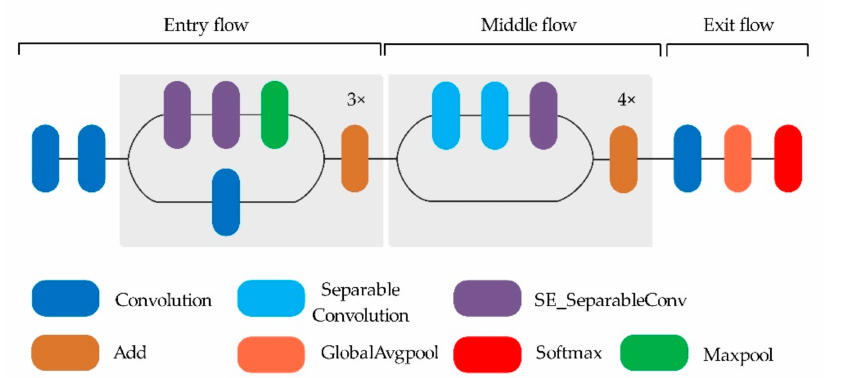
Figure 5. The network structure of